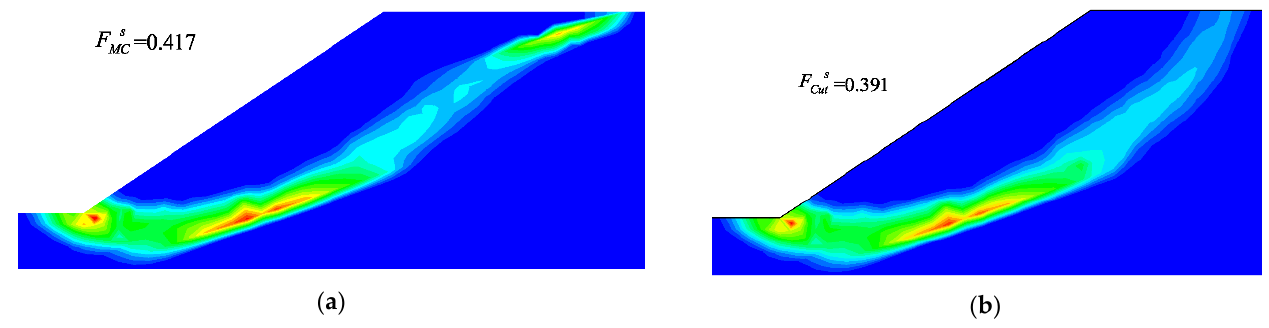
Figure 9. Distributions of the equivalent plastic strain. ( a ) intact M–C; ( b ) cut-off M–C.